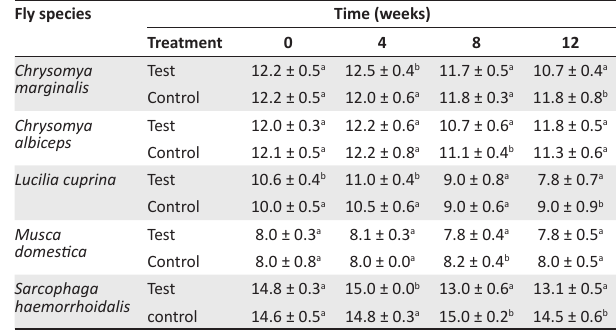
TABLE 2: Sizes (mean ± s.d.) (mm) of the different fly species captured from the treated farm during a 12-week period. Fly species Time (weeks)